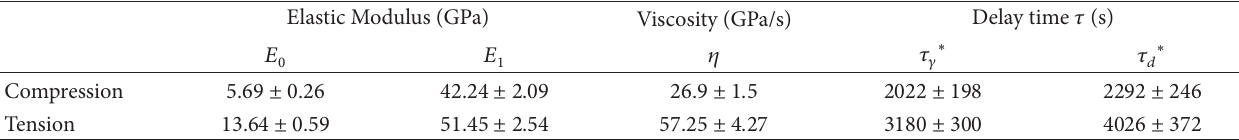
Table 1: Coefficients for the viscoelastic properties for human skull.